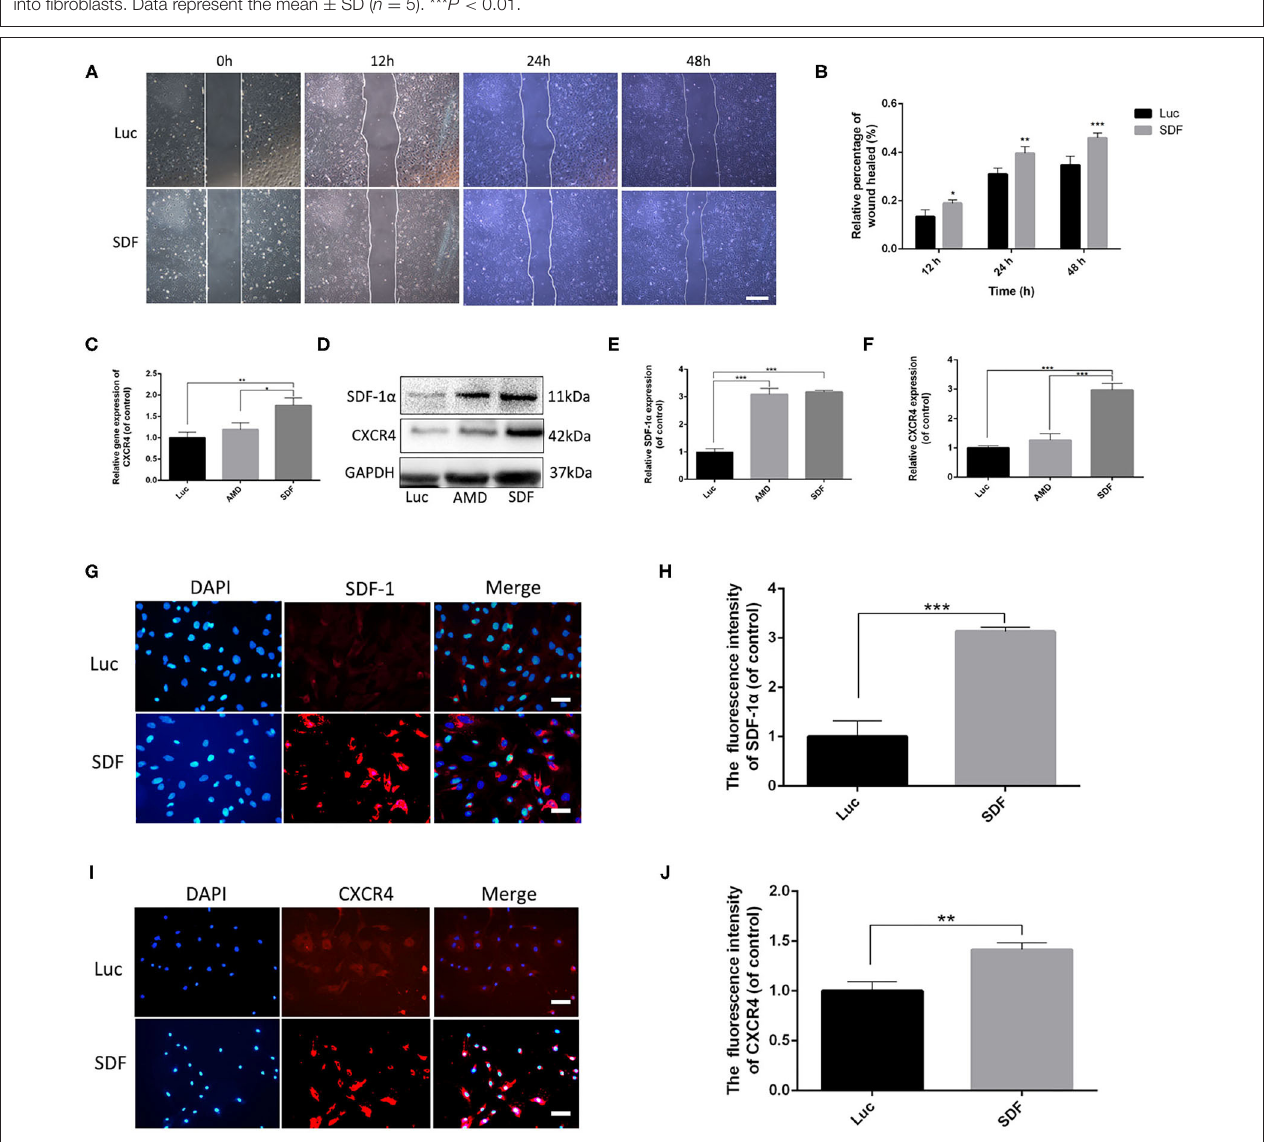
FIGURE 2 | Flow cytometric analysis of transfection efficiency 24h post-transfection. (D) The expression of SDF-1 α gene in fibroblasts was evaluated by qRT-PCR. (E) SDF-1 α concentrations in culture supernatants of SDF-1 α modRNA into fibroblasts. (F) Cumulative SDF-1 α concentration after transfection of SDF-1 α modRNA